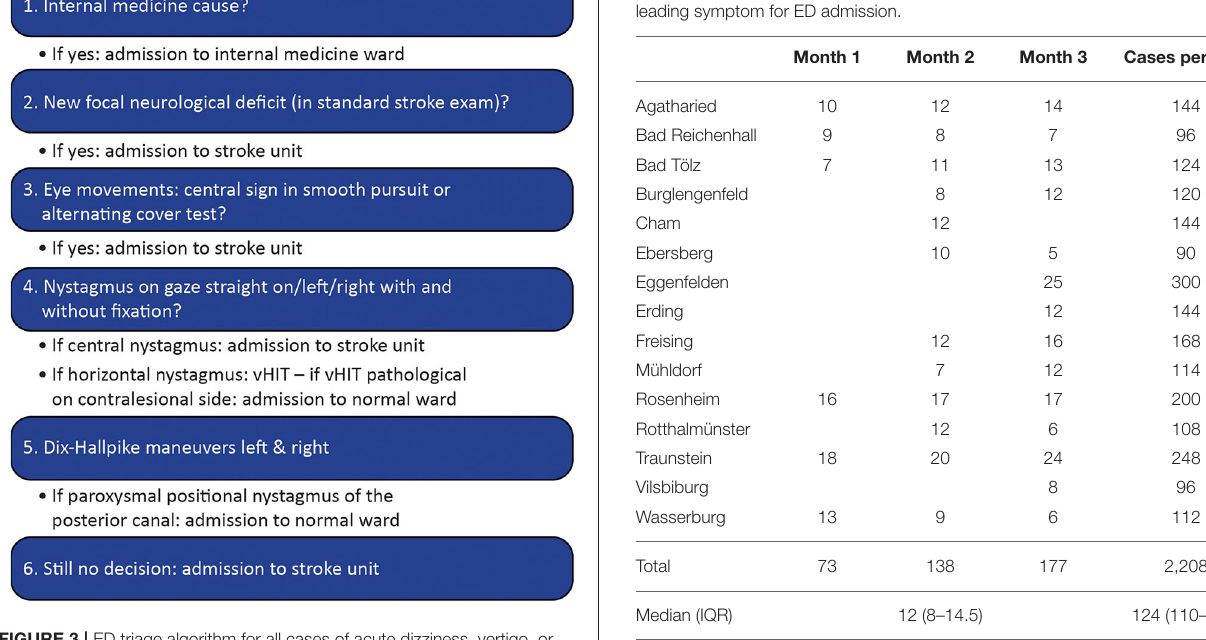
FIGURE 3 | ED triage algorithm for all cases of acute dizziness, vertigo, or imbalance.